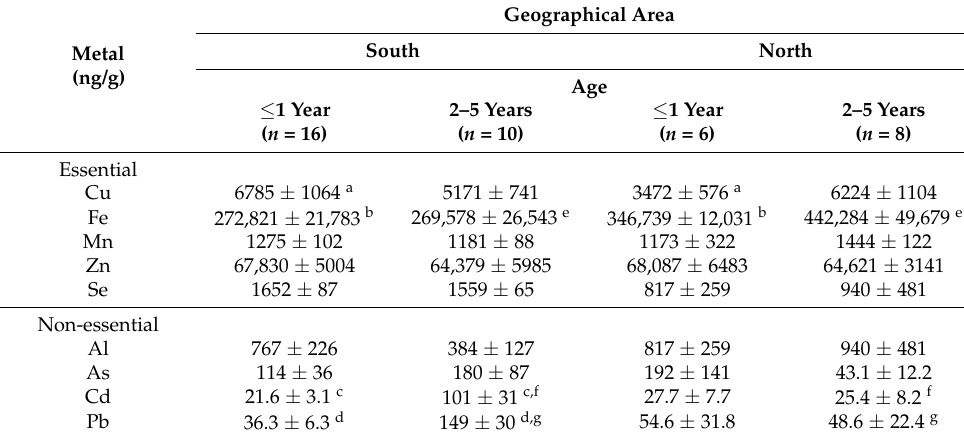
Table 2. The levels of essential and non-essential metals (mean ± SEM) in ovarian tissues of selected age groups of free-ranging queens.